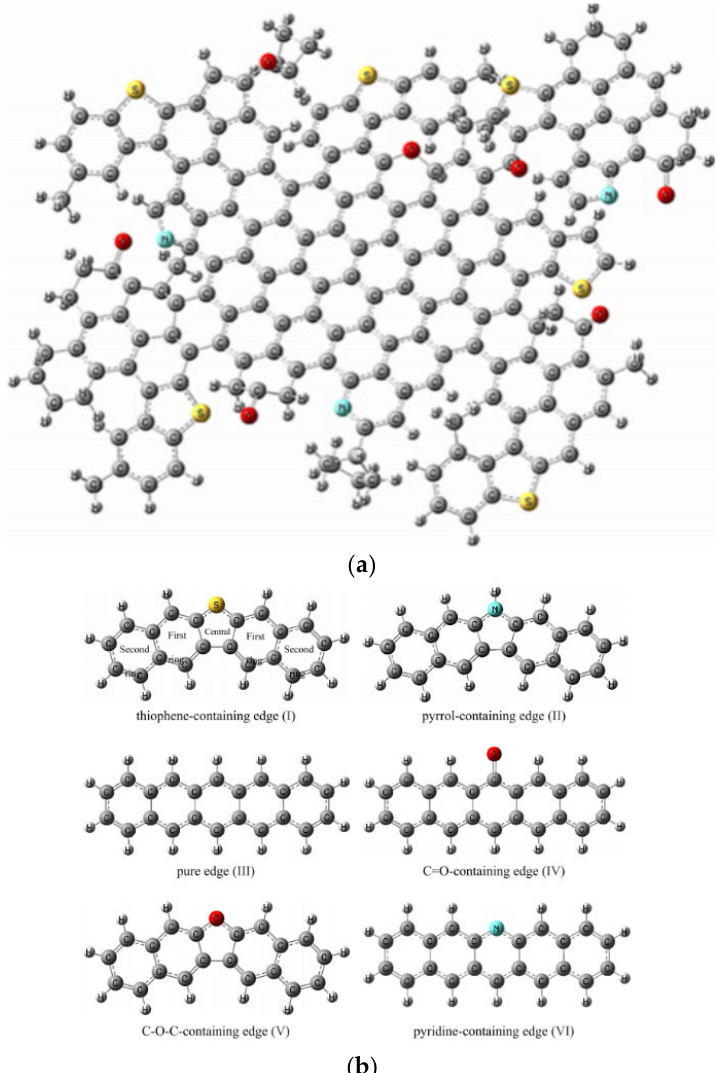
Figure 8. ( a ) Large-scale molecular model of HSPC [69] Reprinted/adapted with permission from Ref. [69]. 2015, Energy and Fuels and ( b ) selected edge model of brominated HSPC [67] . Reprinted/adapted with permission from Ref. [67]. 2019, Energy and Fuels.